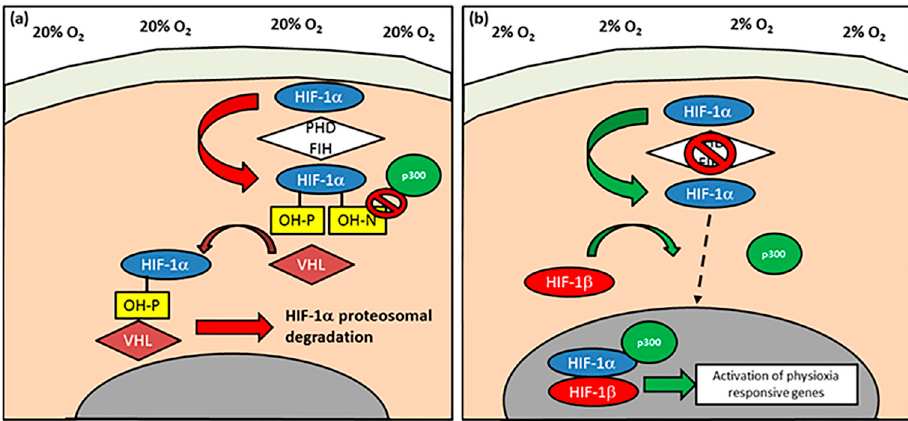
Figure 2. Schematic diagram describing the activation of hypoxia-inducible factor-1 alpha ( HIF-1 α ). ( a ) Under normoxic/hyperoxic (20% oxygen) conditions, HIF-1 α is hydroxylated by prolyl hydroxylases (PHDs) and factor inhibiting HIF (FIH) that enables HIF-1 α to undergo proteasomal degradation by von-Hippel-Lindau (VHL) E3 ubiquitin ligase complex. In contrast, PHD and FIH activity is inhibited under ( b ) hypoxia/physioxia (2% oxygen), thus leading to nuclear translocation of HIF-1 α that forms a complex with HIF-1 β and co-factor p300, that results in upregulation of physioxia-responsive genes. Arrows describe the flow and stages involved in HIF-1 α behavior under ( a ) normoxia/hyperoxia and ( b ) hypoxia/physioxia (dotted arrow depicts HIF-1 α nuclear translocation).